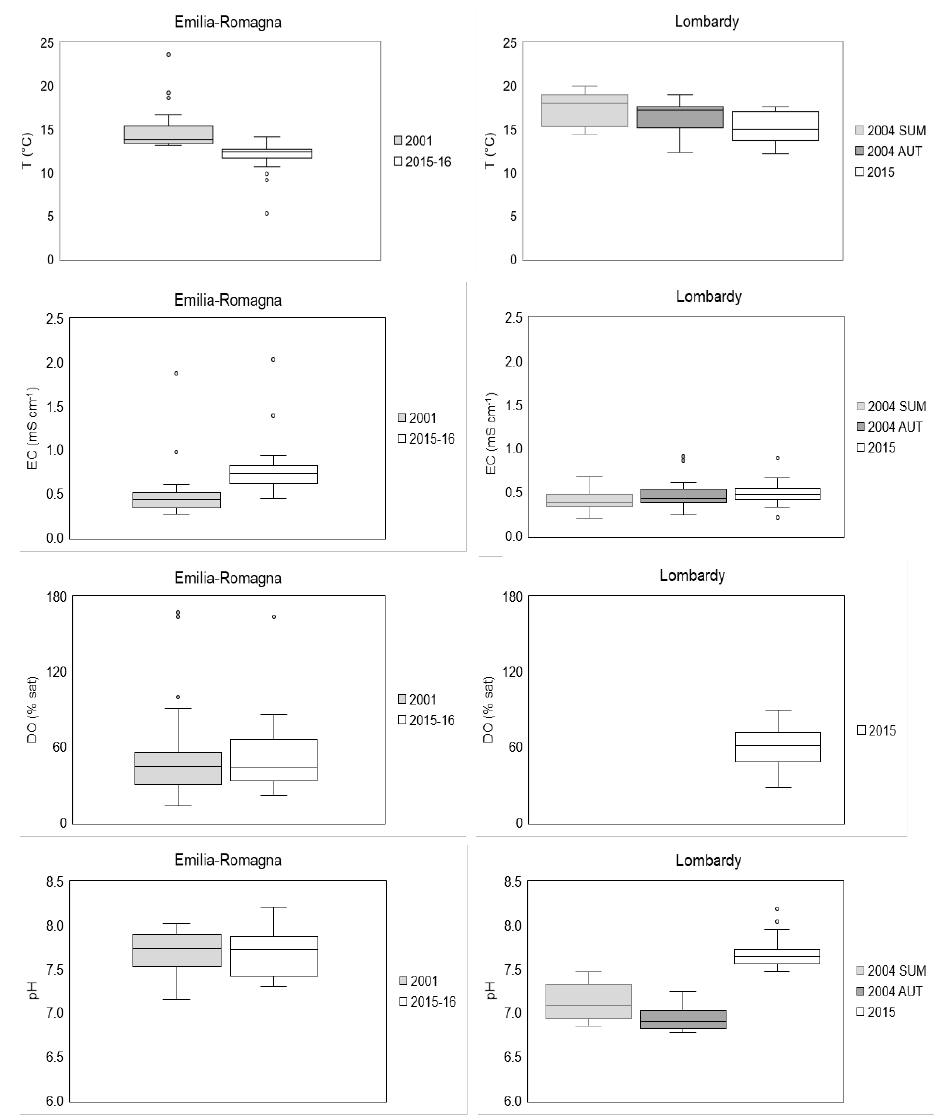
Figure 2. Box-plots showing comparison between water temperature (T), conductivity (EC), dissolved oxygen (DO) and pH values measured in the present study and in previous research [10,15]. The boxes show the 25th and 75th percentile (interquartile) ranges. Median values are shown as a horizontal black bar in each box. The whiskers extend up from the top of the box to the largest value that is ≤ 1.5 times the interquartile range, and down from the bottom of the box to the smallest value that is > 1.5 times the interquartile range. Values outside this range are considered as outliers and are represented by dots. SUM: summer; AUT: autumn. No DO data available for springs of Lombardy in 2004.